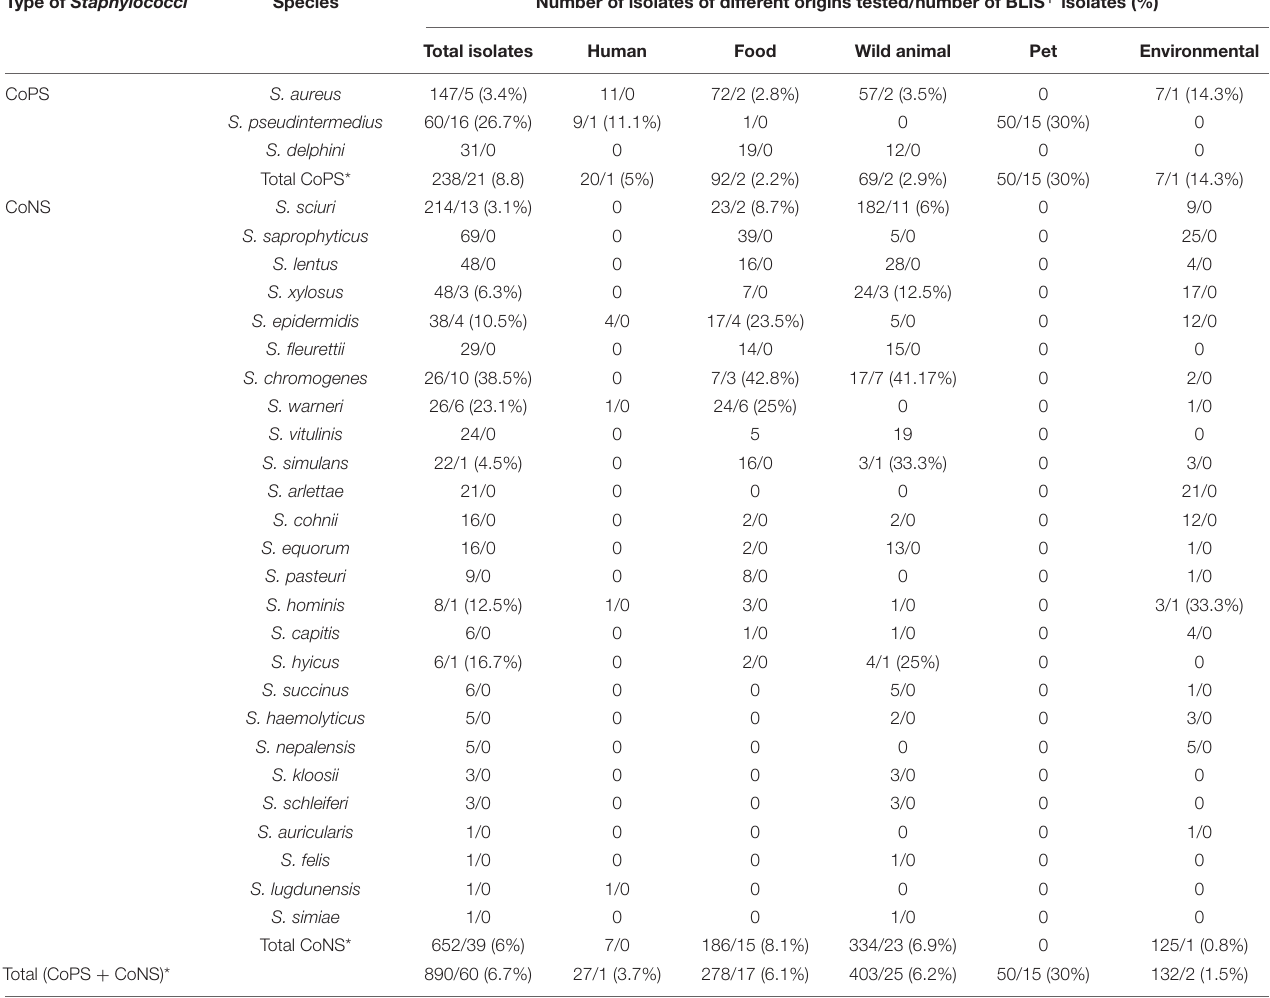
TABLE 1 | Species, origins, and bacteriocin-like inhibitory substances (BLIS) production capacity of the 890 CoPS and CoNS isolates included in this study. Type of